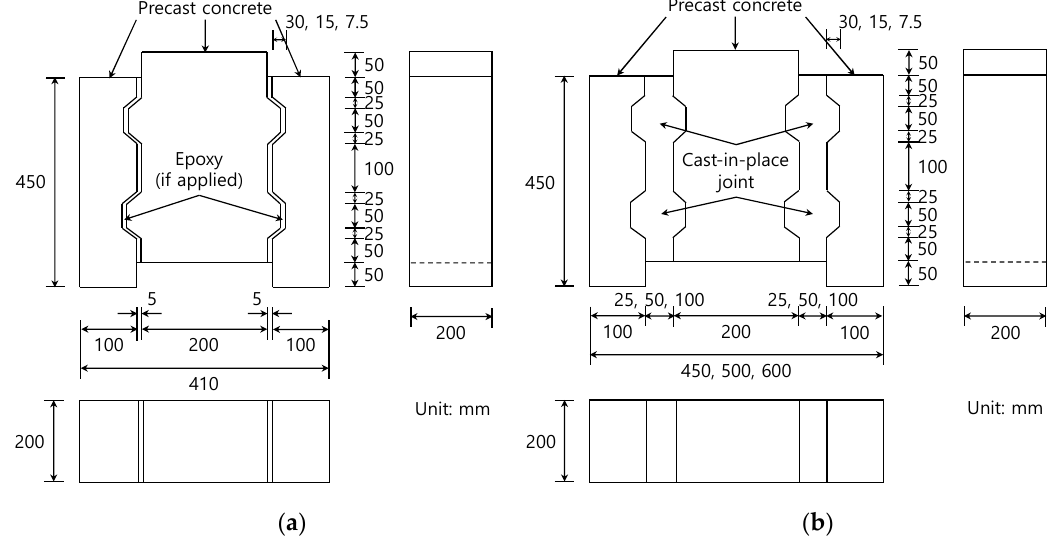
Figure 2. Dimensions of test specimens with two shear keys: ( a ) dry joint; and ( b ) wet joint.